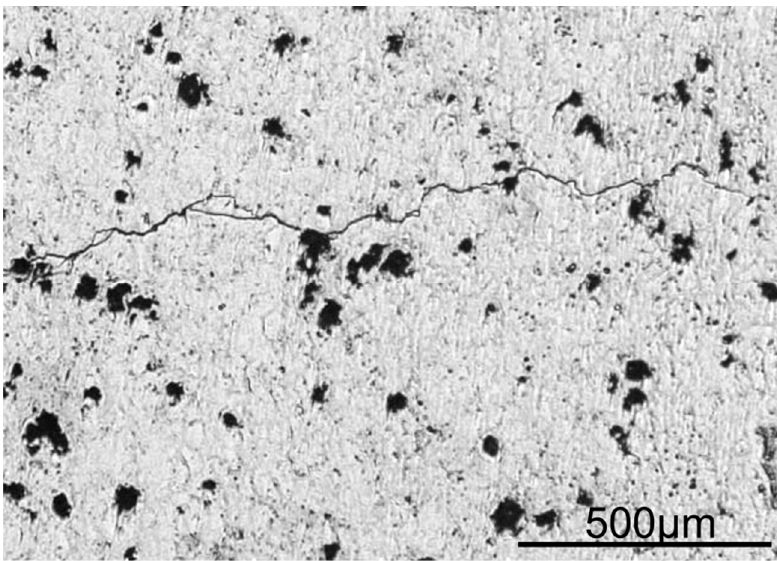
Figure 12. Typical crack path (left → right) in APS-yttria with deflections and bifurcations; the crack propagation of this sample is in the through-thickness direction (vertical).